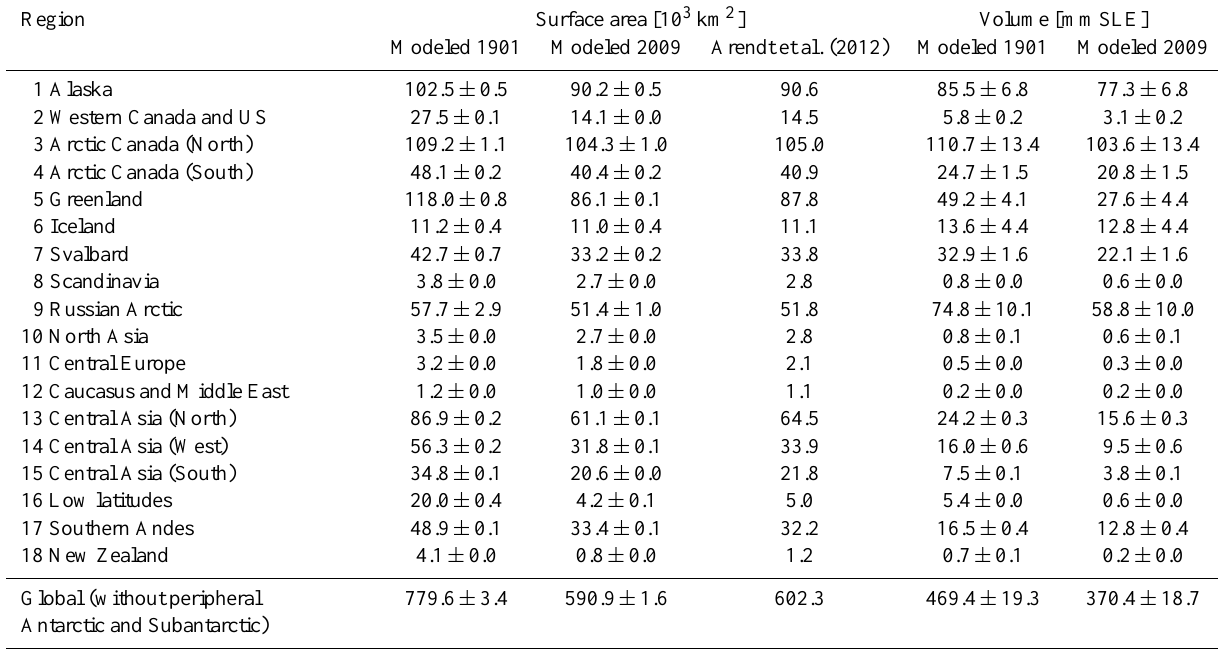
Fig. 16. Validation of temporally integrated modeled volume changes and surface areas, and propagated model errors; (a) relative volume error as a function of glacier surface area; (b) relative surface area error as a function of glacier surface area; (c) relative volume error as a function of the mean distance to the 10 closest sampled glaciers; (d) relative surface area error as a function of the mean distance to the 10 closest sampled glaciers; solid dots indicate non-calving glaciers; rings indicate calving glaciers; numbers indicate correlations (gray/black: below/above 95% confidence interval). Table 3. Reconstructed surface areas and ice volumes in 1901 and 2010, compared to measured surface areas. Note that the measurements contained in Arendt et al. (2012) span several years, and regional sums therefore cannot be assigned to a specific year.